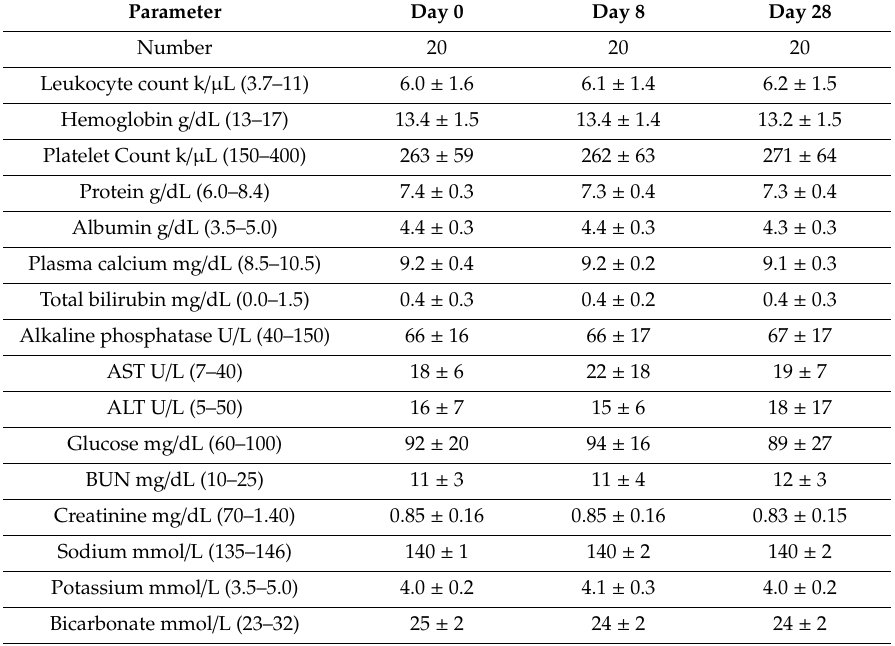
Table 2. Clinical laboratory parameters.